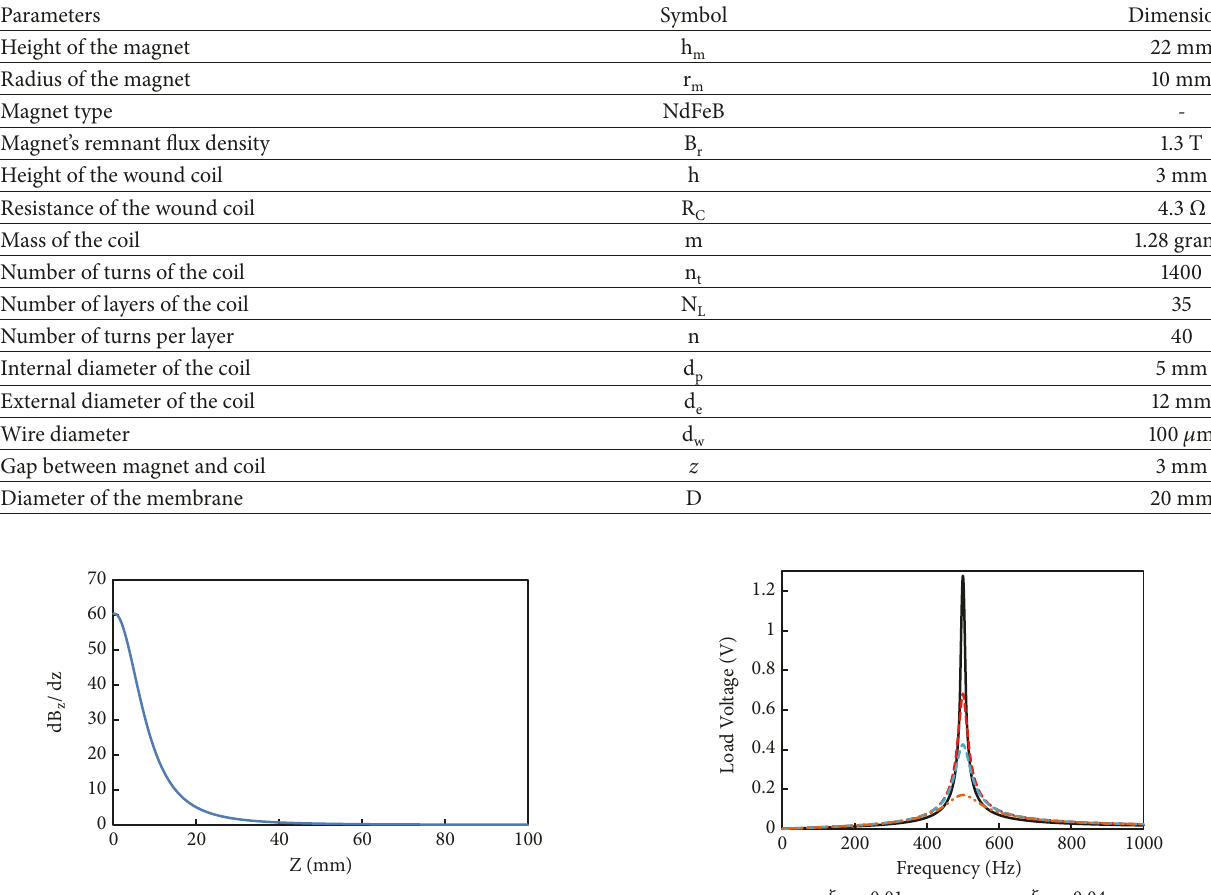
Figure 7: Magnetic flux density gradient vs. distance from the surface of the magnet to the coil.